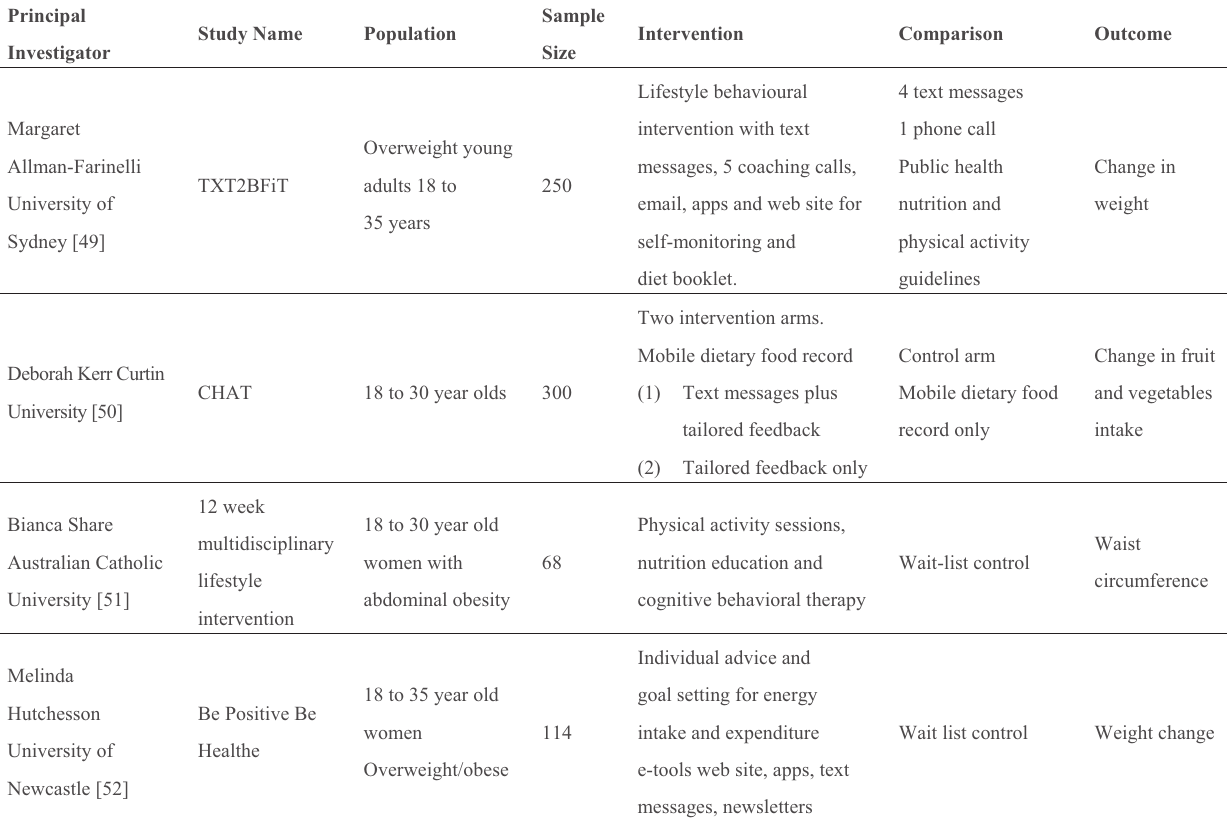
Table 2. Registered clinical trials in Australia in young